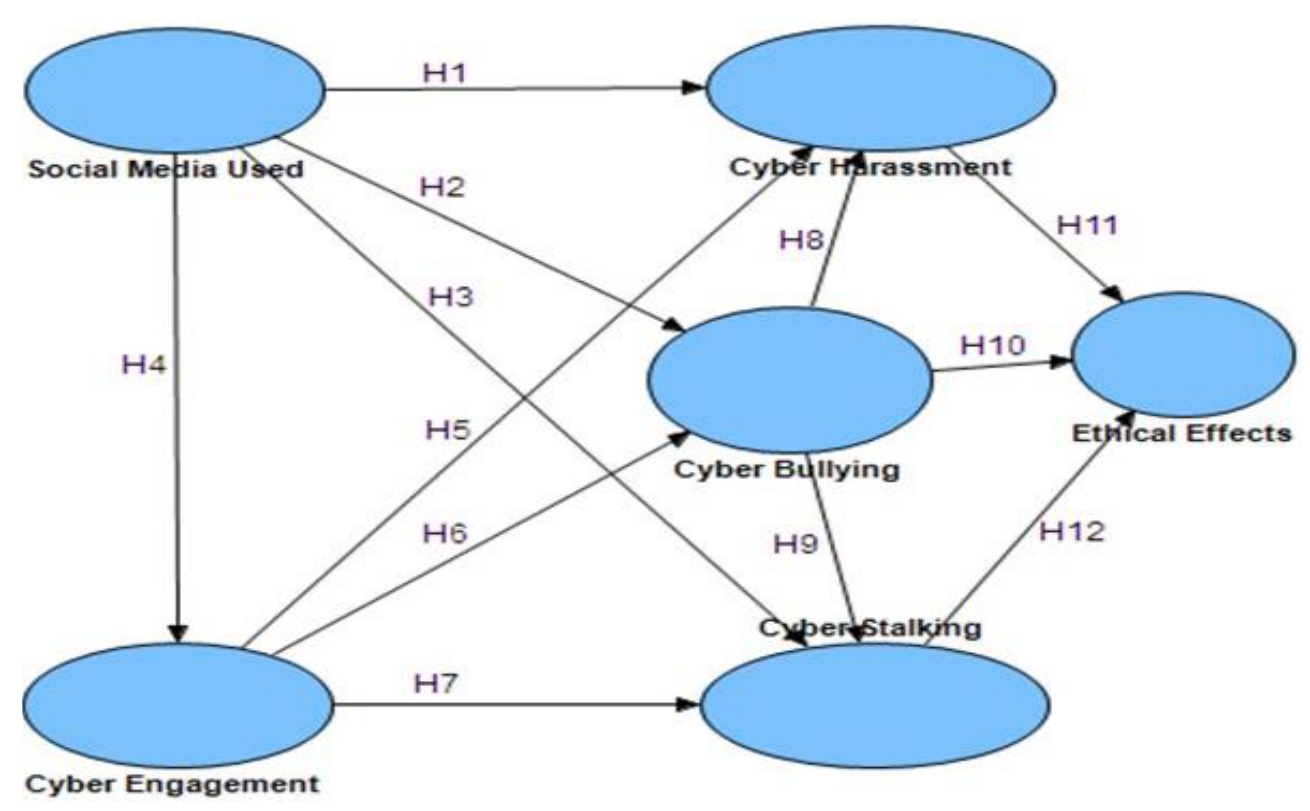
Figure 1. Research model.